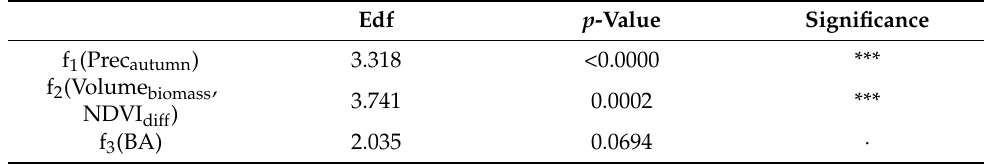
Table 3. Parameters describing the smoother functions of the model of Lactarius deliciosus yield, where the significance codes are for a p -value = 0 ‘***’, p -value = 0.05 ‘ · ’. Edf p